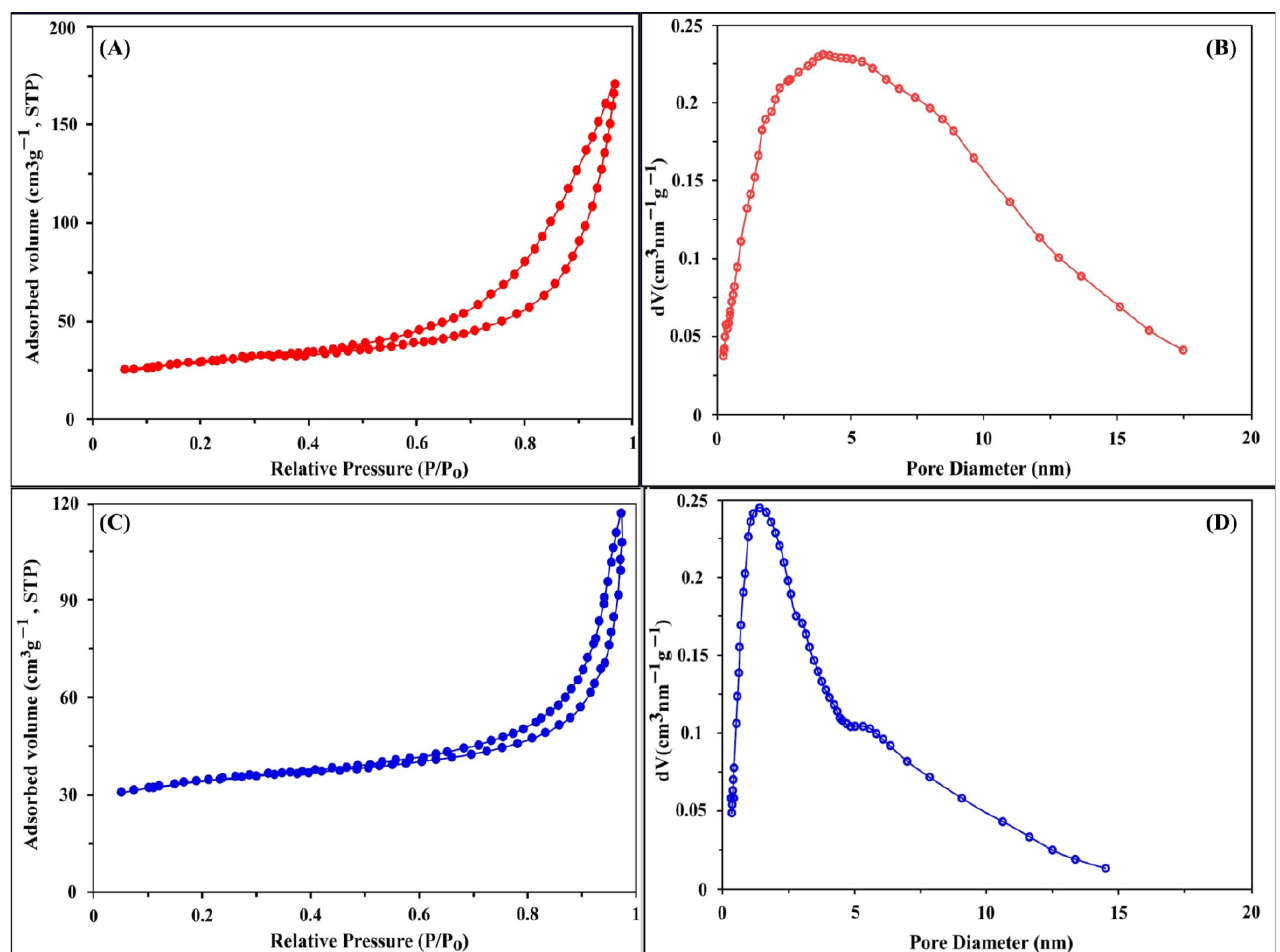
Figure 2. ( A , C ) N 2 sorption/desorption isotherms of HNAP and HNAP/QA, and ( B , D ) pore volume distribution of HNAP and HNAP/QA.